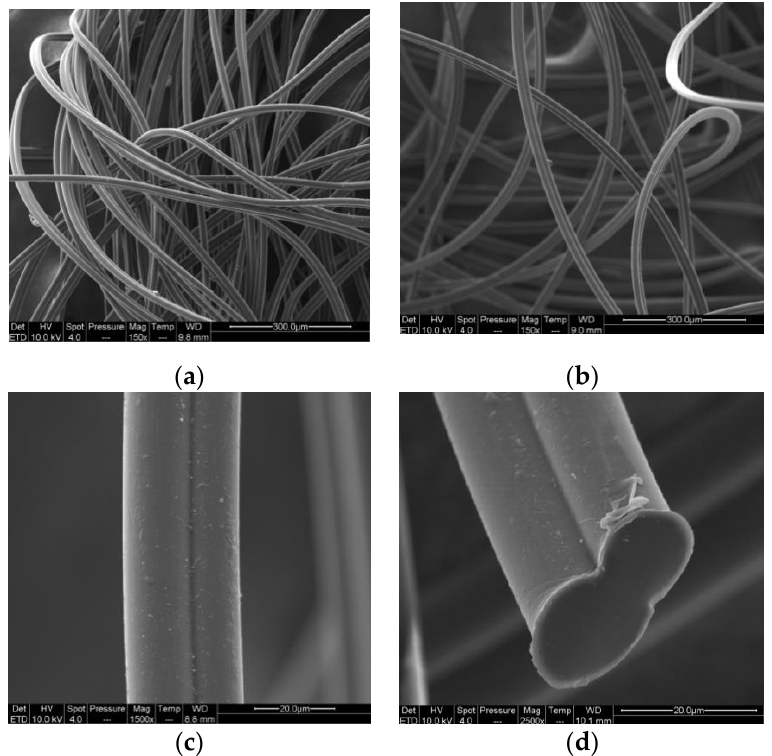
Figure 3. Scanning electron micrographs of bicomponent filaments. ( a , b ) Configuration of filaments in the yarn; ( c ) Lengthwise view; ( d ) Cross section view.